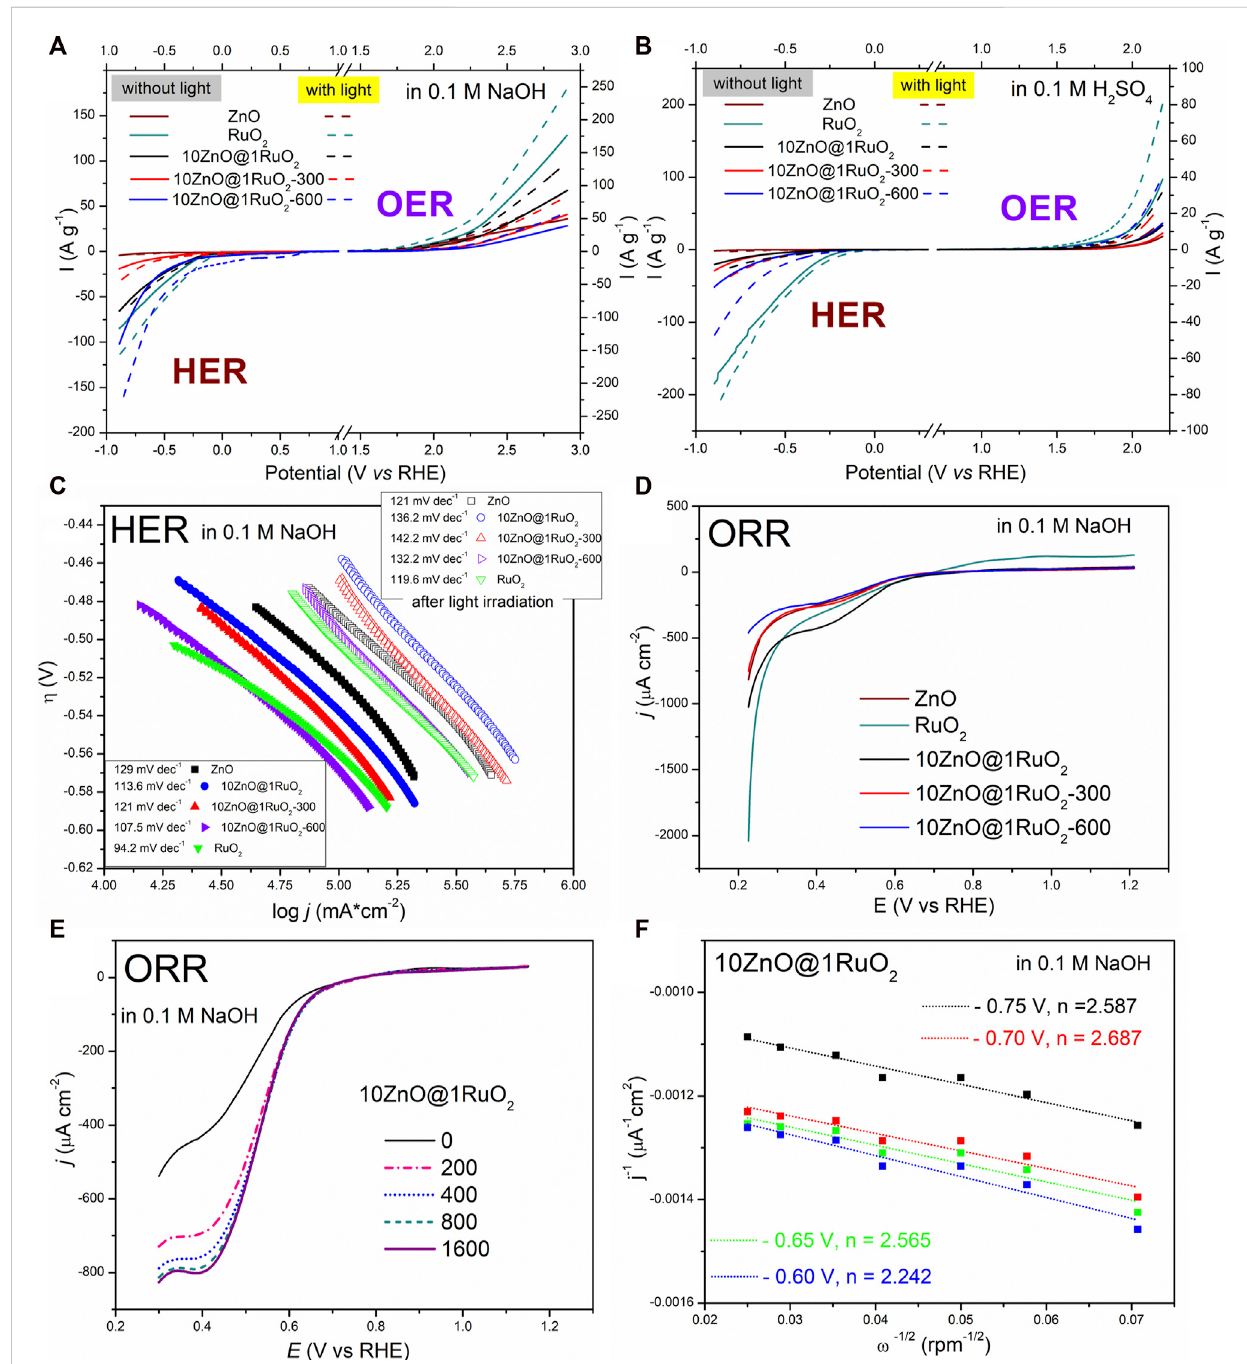
FIGURE 9 HER/OER LSVs of thecatalyst photoelectrodes in (A) 0.1 MNaOH and (B) 0.1 MH 2 SO 4 solution,atascan rate of20 mV s − 1 inthe dark condition and underlightillumination. (C) TafelplotsderivedfromtheLSVsin (A) . (D) ORRLSVsforthecatalystsin0.1 MNaOH. (E) ORRLSVsfor10ZnO@1RuO 2 in0.1 M NaOH at rotation rates of 200 – 1,600 rpm and a scan rate of 5 mV · s − 1 . (F) Koutecky – Levich plot of 10ZnO@1RuO 2 based on the ORR polarization curves in (E)